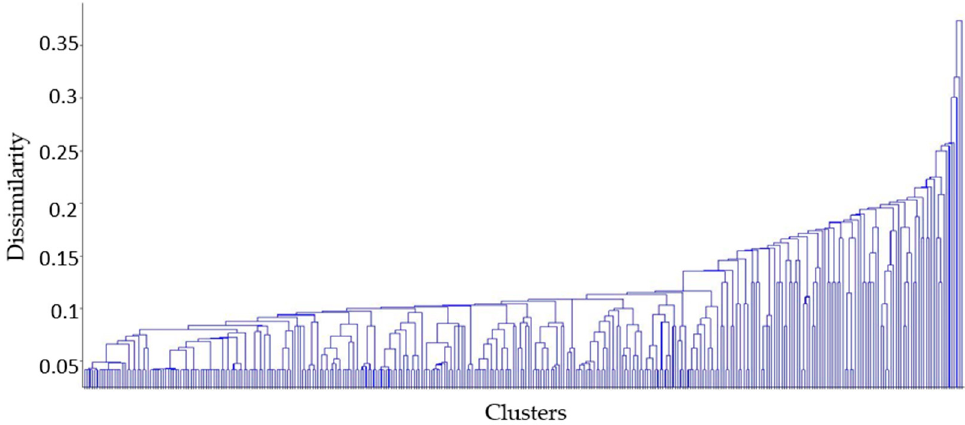
Figure 10. Dendrogram of hierarchical clustering.